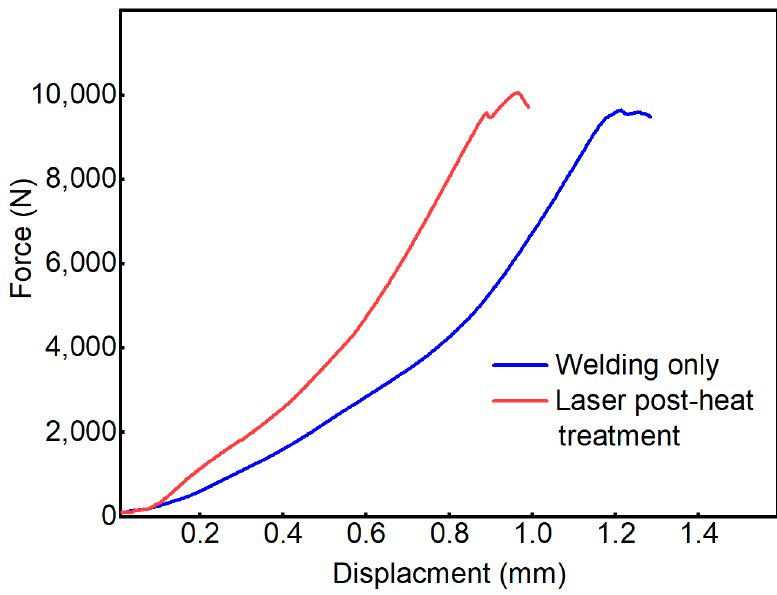
Figure 16. Force–displacement curves.